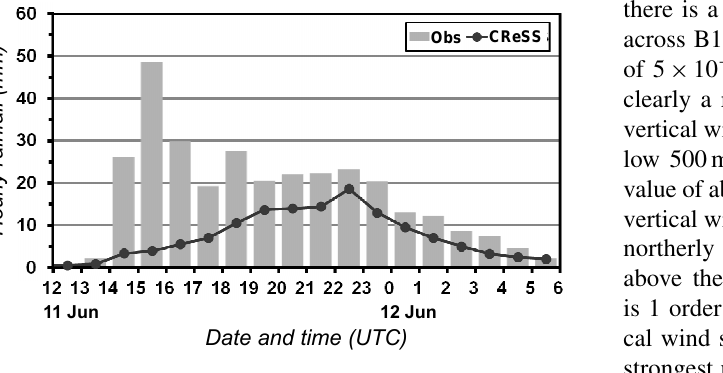
Figure 8. Time series of observed (gray bars) and simulated (curve with dots) hourly rainfall (mm), averaged inside the box shown in Fig. 5b (24.75–25.17 ◦ N, 120.87–121.85 ◦ E) over northern Taiwan from 12:00UTC on 11 June to 06:00UTC on 12 June